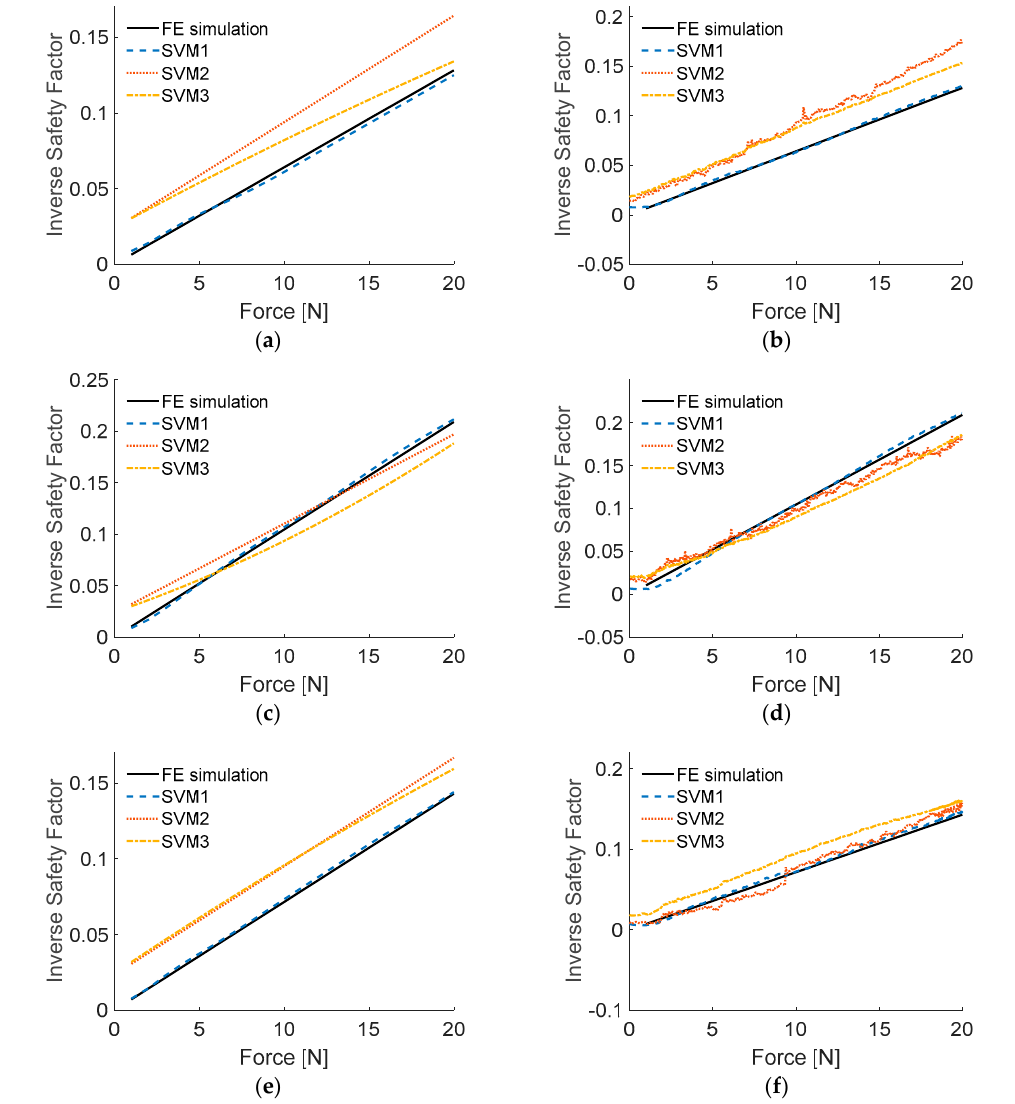
Figure 9. Results of testing SVM models: ( a ) load case LC1, numerical input data; ( b ) load case LC1, experimental input data; ( c ) load case LC2, numerical input data; ( d ) load case LC2, experimental input data; ( e ) load case LC3, numerical input data; ( f ) load case LC3, experimental input data.